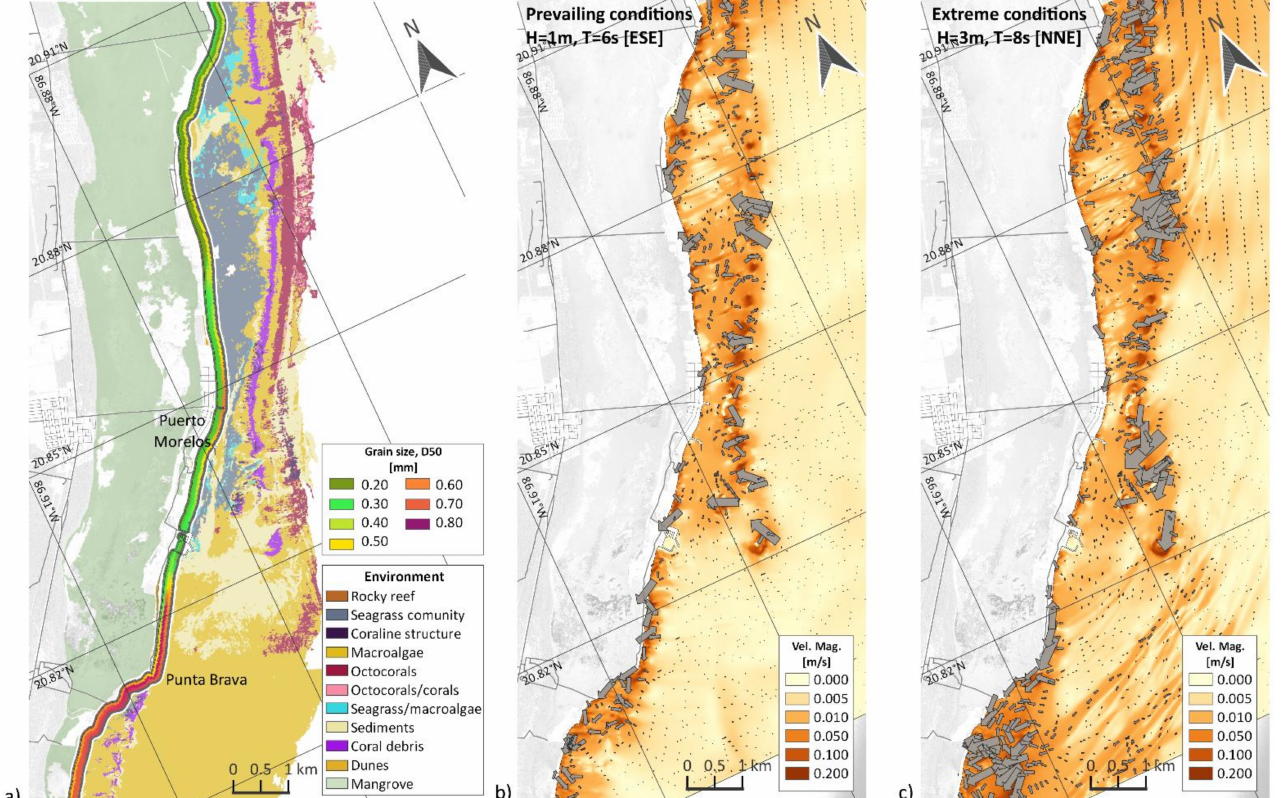
Figure 9. Results for Puerto Morelos showing ( a ) land use and variation of the sediment grain size (D 50 ). Sediment grain size variation is depicted over a strip of 150 m width along the shoreline considering sand samples at the backshore, nearshore and foreshore zones. The speed and direction of wave-induced currents is also shown for ( b ) prevailing [HS = 1 m, TP = 6 s, θ = 112.5 ◦ (ESE)] and ( c ) extreme conditions [HS = 3 m, TP = 8 s, θ = 22.5 ◦